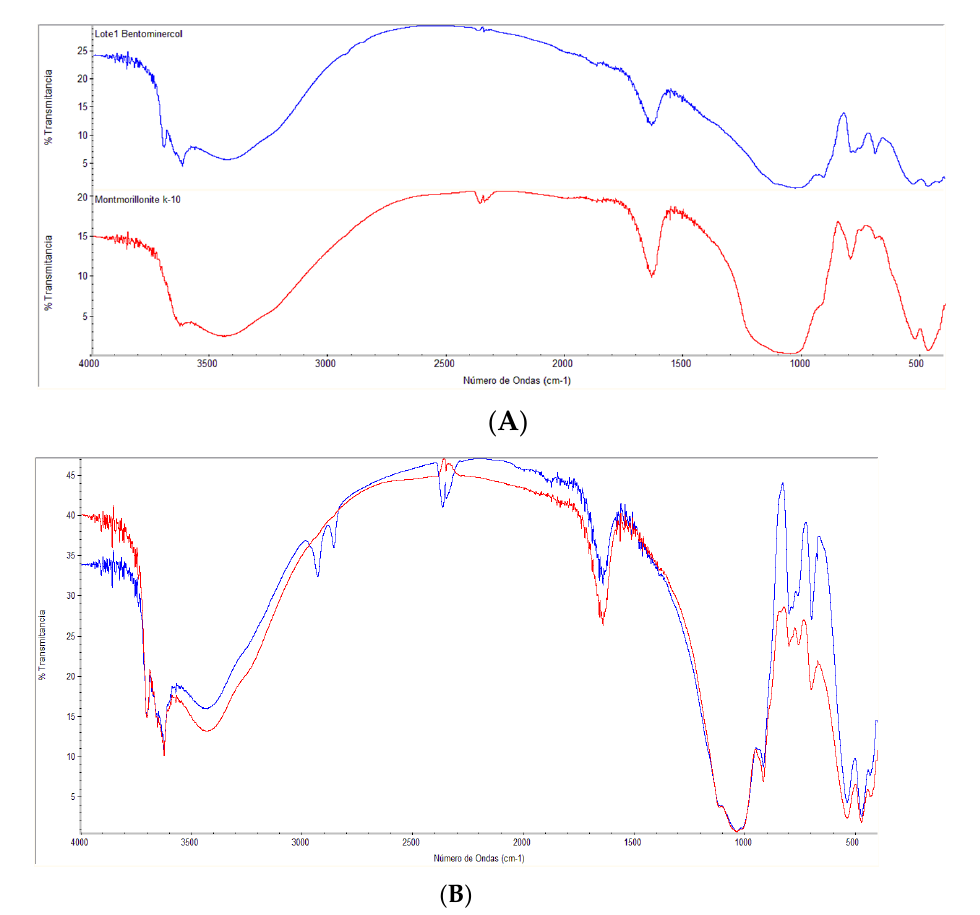
Figure 4. FTIR spectra ( A ) of the purified raw bentonite clay and the Sigma Aldrich K10 montmorillonite standard, and ( B) the raw (red) and modified (blue) bentonite clay.